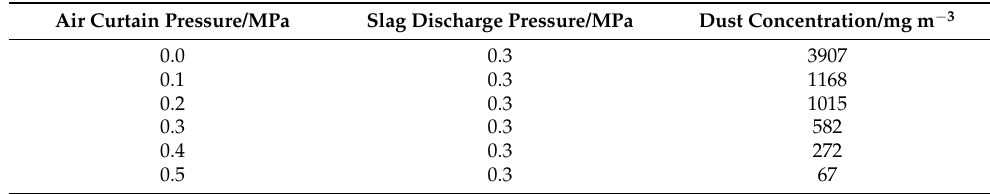
Table 6. Results of dust-concentration field test.